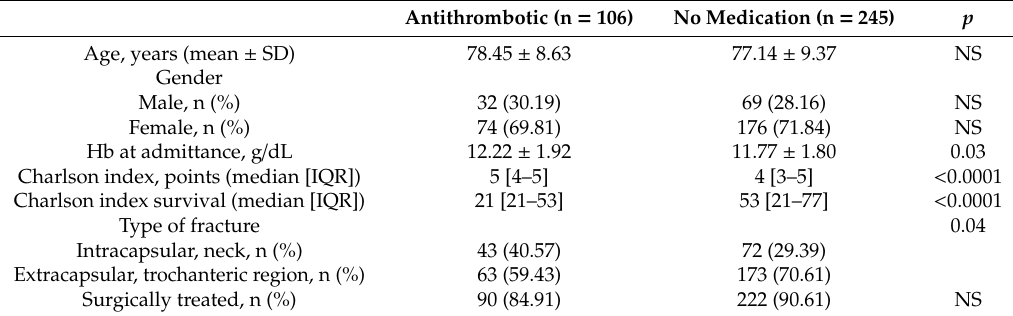
Table 1. All hip fracture